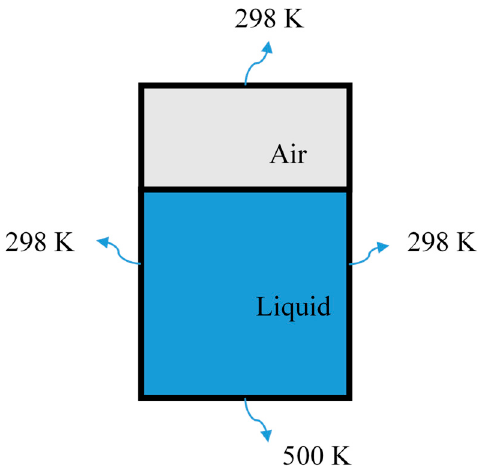
Figure A1. Schematic of a benchmark two-phase system for validating our new module.